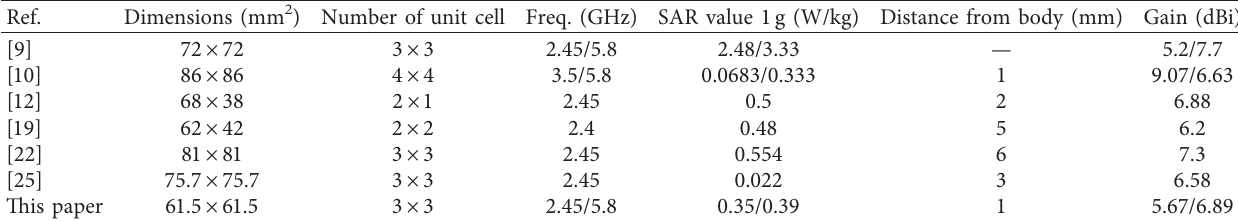
Table 2: Comparison of the proposed antenna with other antennas reported in the literature.